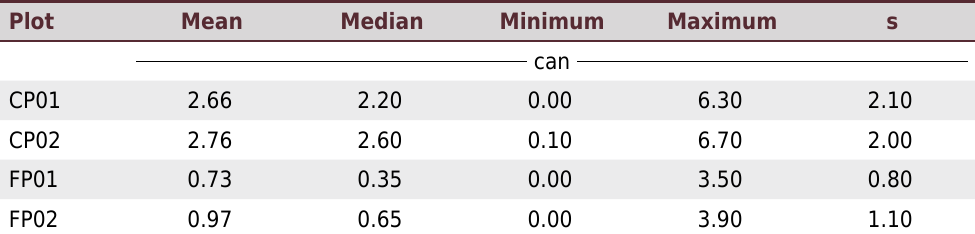
Table 1. Descriptive statistics of total fruit production measured in cans in the Brazil nut stands Cachoeira - Plots CP01 and CP02 and Filipinas - Plots FP01 and FP02